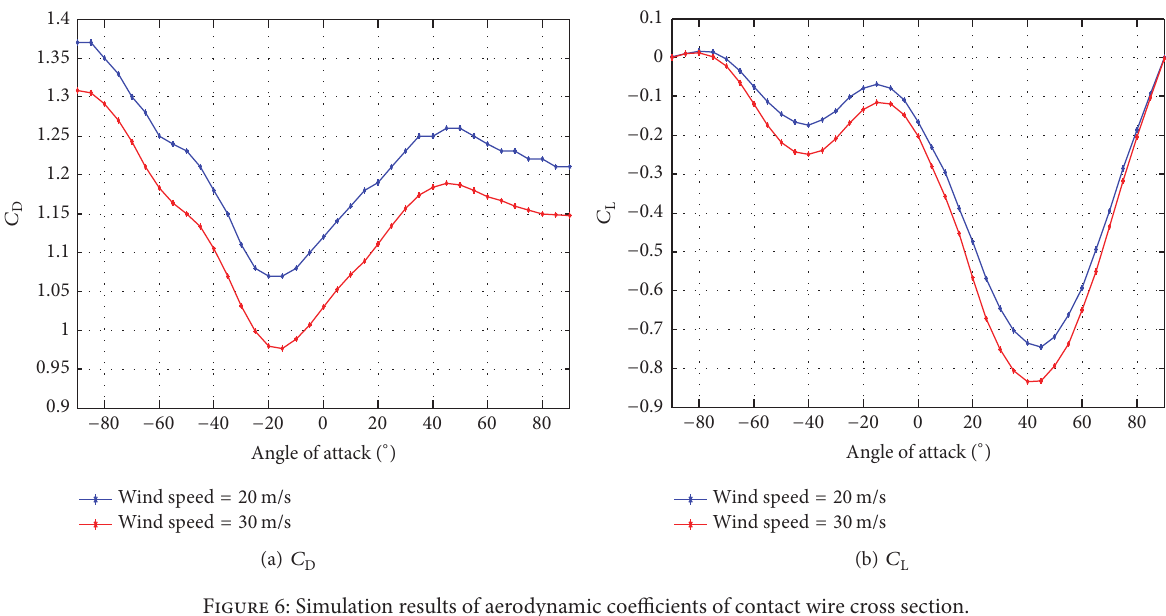
Figure 6: Simulation results of aerodynamic coefficients of contact wire cross section.